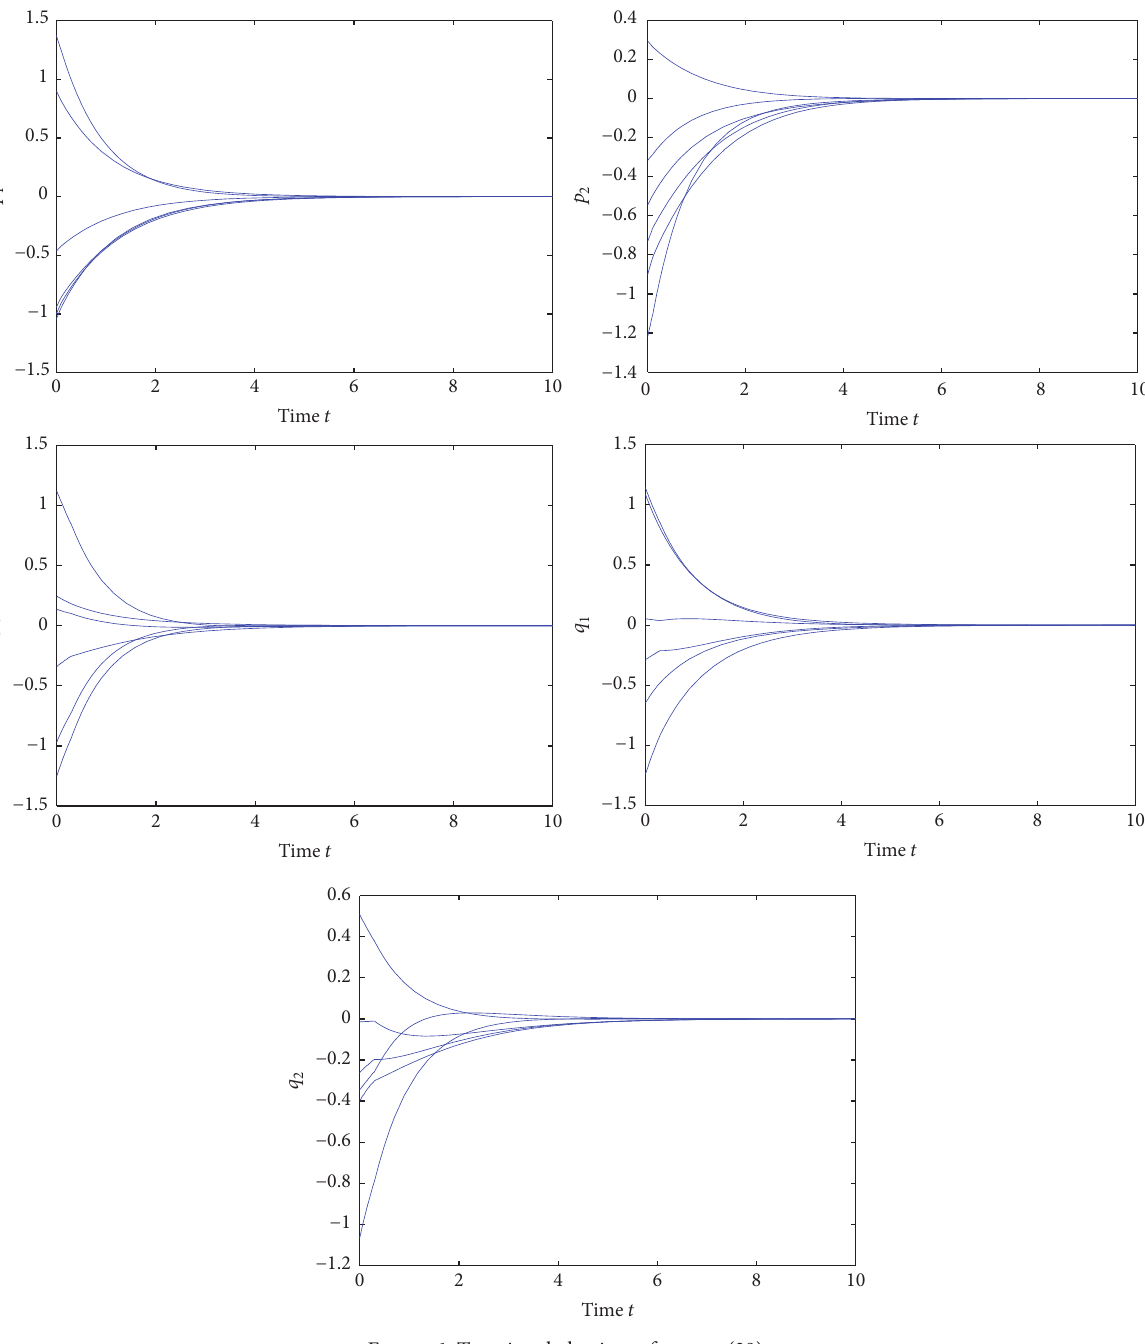
Figure 1: Transient behaviors of system